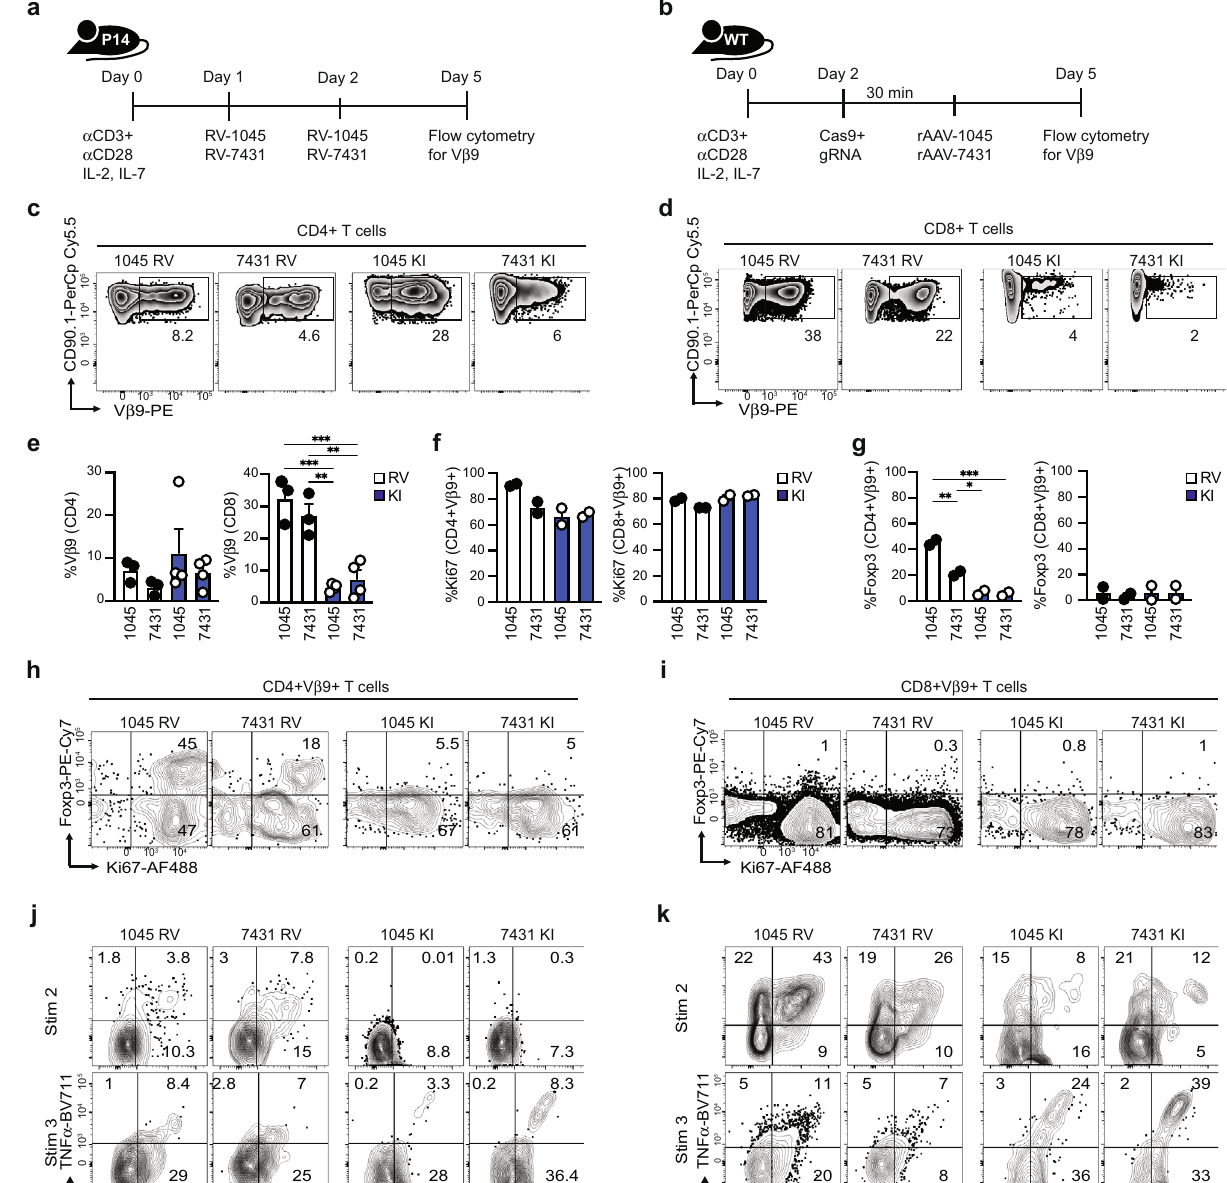
Fig.2|TargetingTCRsto Trac